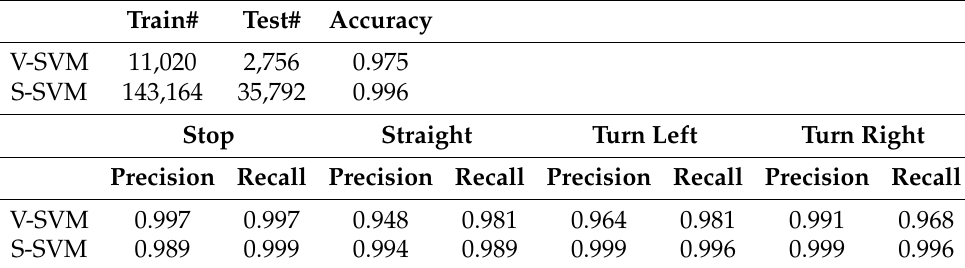
Table 2. Evaluation of SVM activity recognition models.